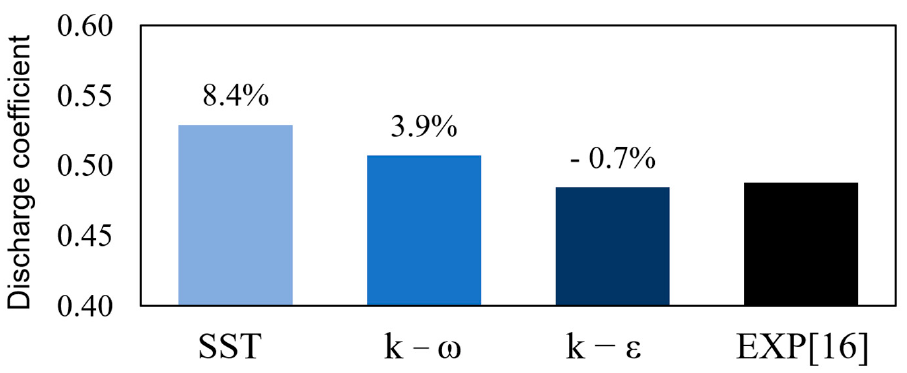
Figure 5. Prediction of the discharge coefficient using the turbulence model.